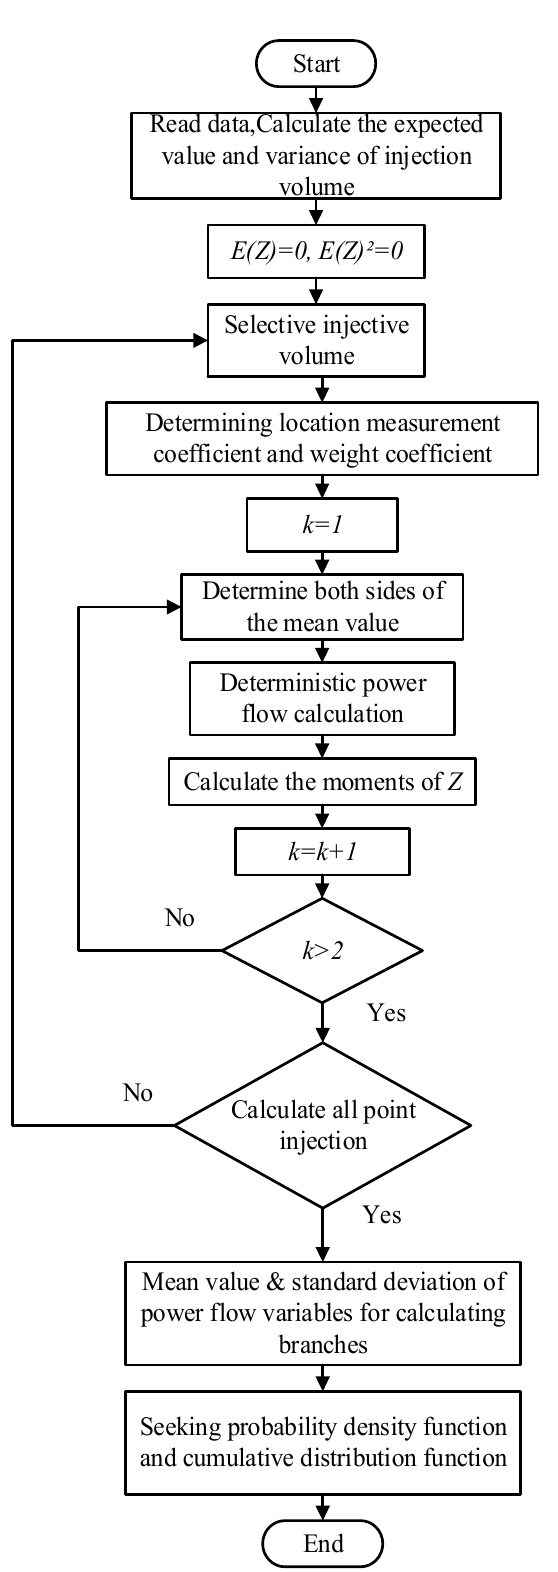
Figure 2. Flow chart of probabilistic power flow calculation based on two ‐ point estimation.